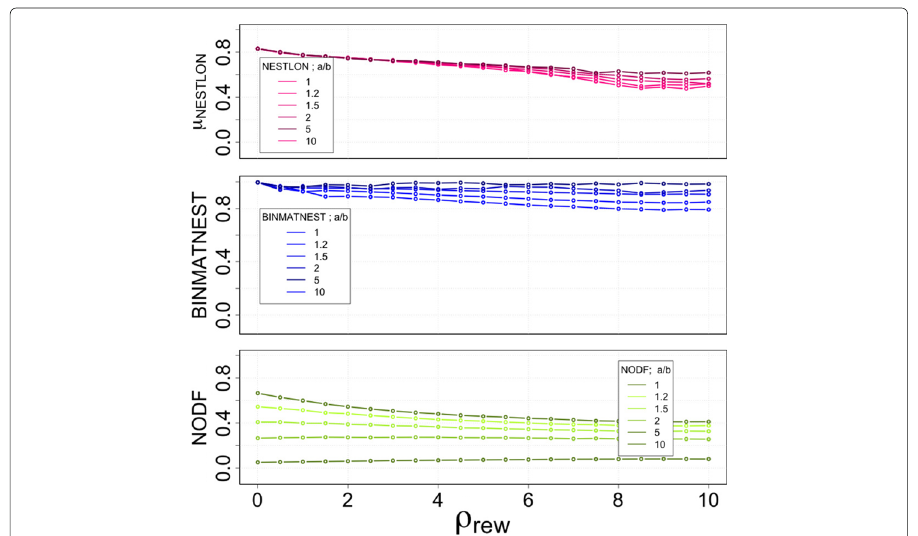
Fig. 8 Sensitivity analysis among NESTLON, BINMATNEST, and NODF on a benchmark graph with an increasing fraction of rewired edges ρ rew . The values of nestedness are almost independent from the shape of the adjacency matrix for the method NESTLON. The variance in nestedness is larger for BINMANEST and NODF compared to NESTLON for differing matrix shapes, n a / n b = { 1,1.2,1.5,2,5,10 } . The variance in nestedness against ρ rew increases for the method BINMATNEST, whereas it decreases for the method NODF. We therefore judge NESTLON as least sensitive in detecting nestedness on bipartite graphs for a broad range of different matrix shapes. We perform the computation on a bipartite benchmark graph with α = 0.49 and a set size of n b = 100 and increasing n